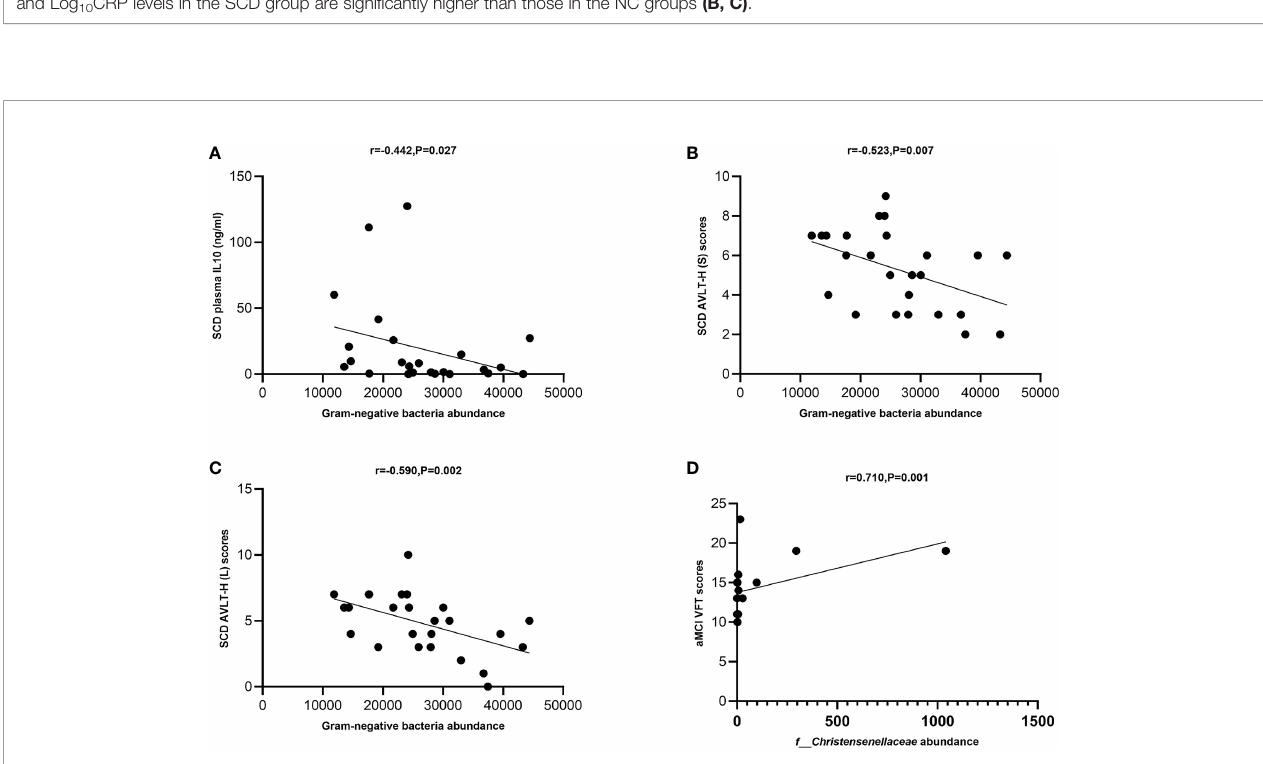
FIGURE 6 | (A – D) Spearman ’ s correlation analysis between Gram-negative bacteria and in fl ammatory factors and neuropsychological assessment of pAD groups. (A) Spearman ’ s correlation analysis outcome shows that the levels of total Gram-negative bacteria were negatively correlated with plasma IL-10 level in the SCD group (Spearman correlation r = − 0.442, P = 0.027; Linear regression equation: Y = − 0.001195*X + 49.42, P = 0.1235). (B, C) The levels of total Gram-negative bacteria were negatively correlated with AVLT-H (S) and AVLT-H (L) respectively in the SCD group (Spearman correlation r = − 0.523, P = 0.007 and r = − 0.590, P = 0.002; Linear regression equation: Y = − 9.806e-005*X + 7.872 and Y = − 0.0001264*X + 8.162, P = 0.0244 and 0.0079). (D) The abundance of the Christensenellaceae family was positively with VFT in the aMCI group (Spearman correlation r = 0.710, P = 0.001; Linear regression equation: Y = 0.006150*X + 13.75, P =